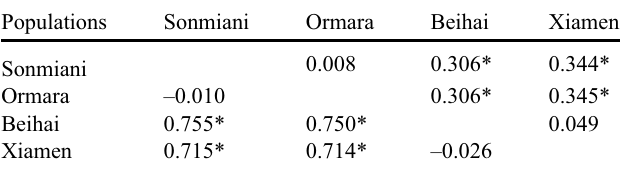
Table 2. P. chinensis pairwise standardized mitochondrial F ST (below diagonal) and microsatellite F ST (above diagonal) values.